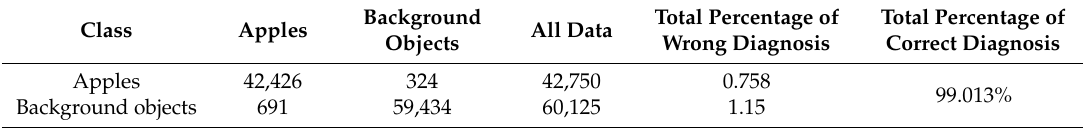
Table 6. Confusion matrix and total percentage of proposed segmentation